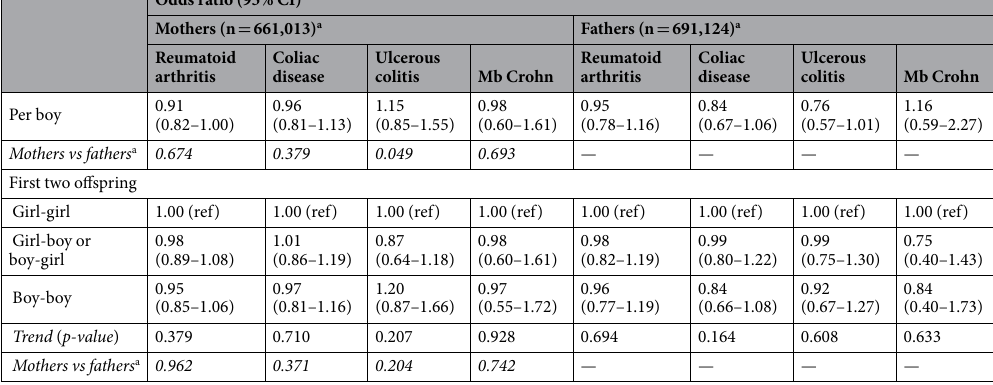
Table 4. Age adjusted odds ratio by some common autoimmune diseases among mothers and fathers by offspring birth composition. p-value a